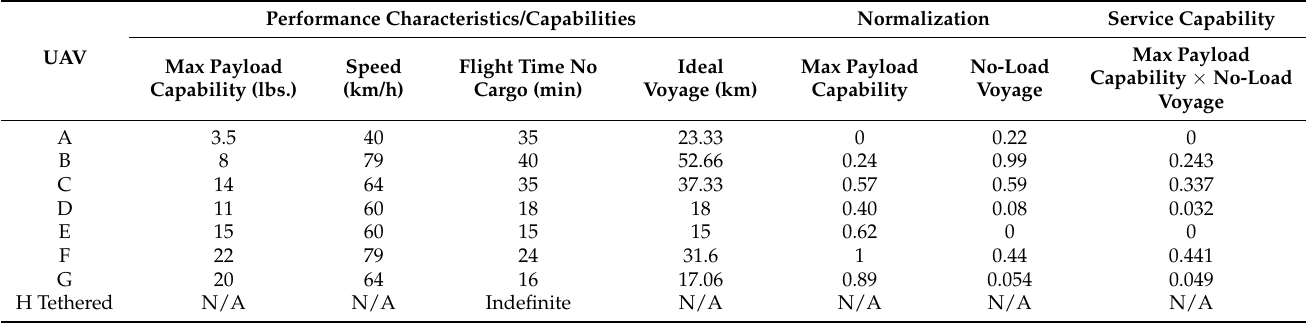
Table 2. The results of normalization.